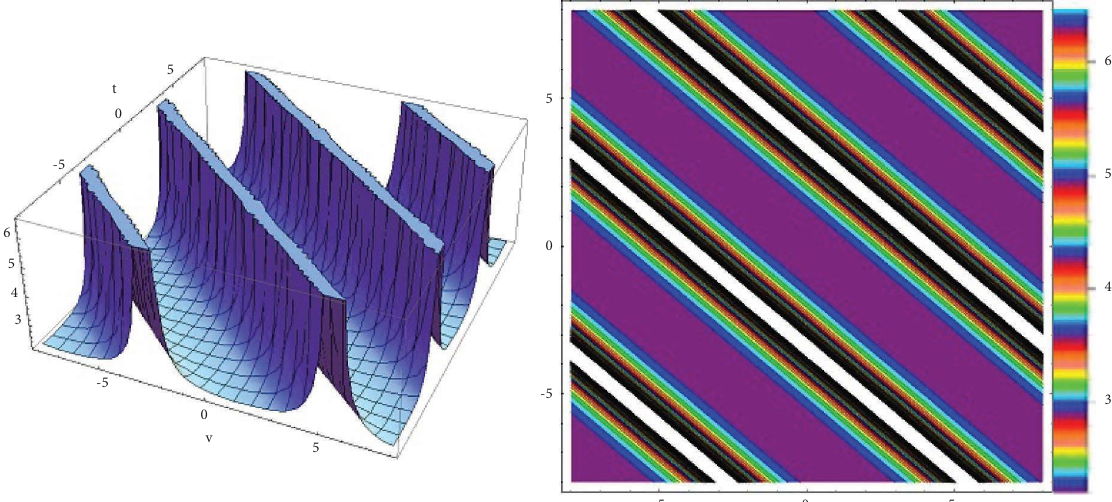
Figure 14: Singular periodic soliton sketching from (44) for ω � 0 . 84.